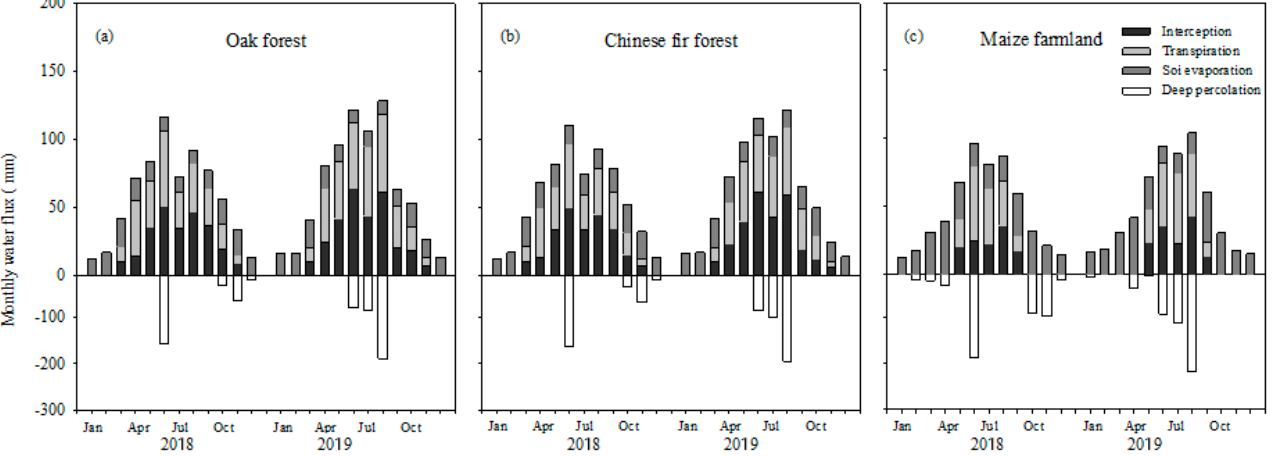
Figure 4. Simulated monthly water fluxes for three plots (drainage and groundwater recharge (deep percolation) are represented by negative values.) Table 4. Simulated annual water balance (in mm) with CoupModel.